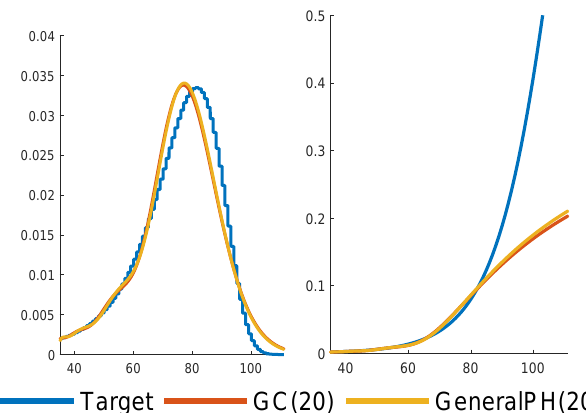
Figure 3. Probability density functions and hazard rate functions for the life table and phase-type (PH) fits using the general and the generalized Coxian (GC) structures with p = 20 phases.